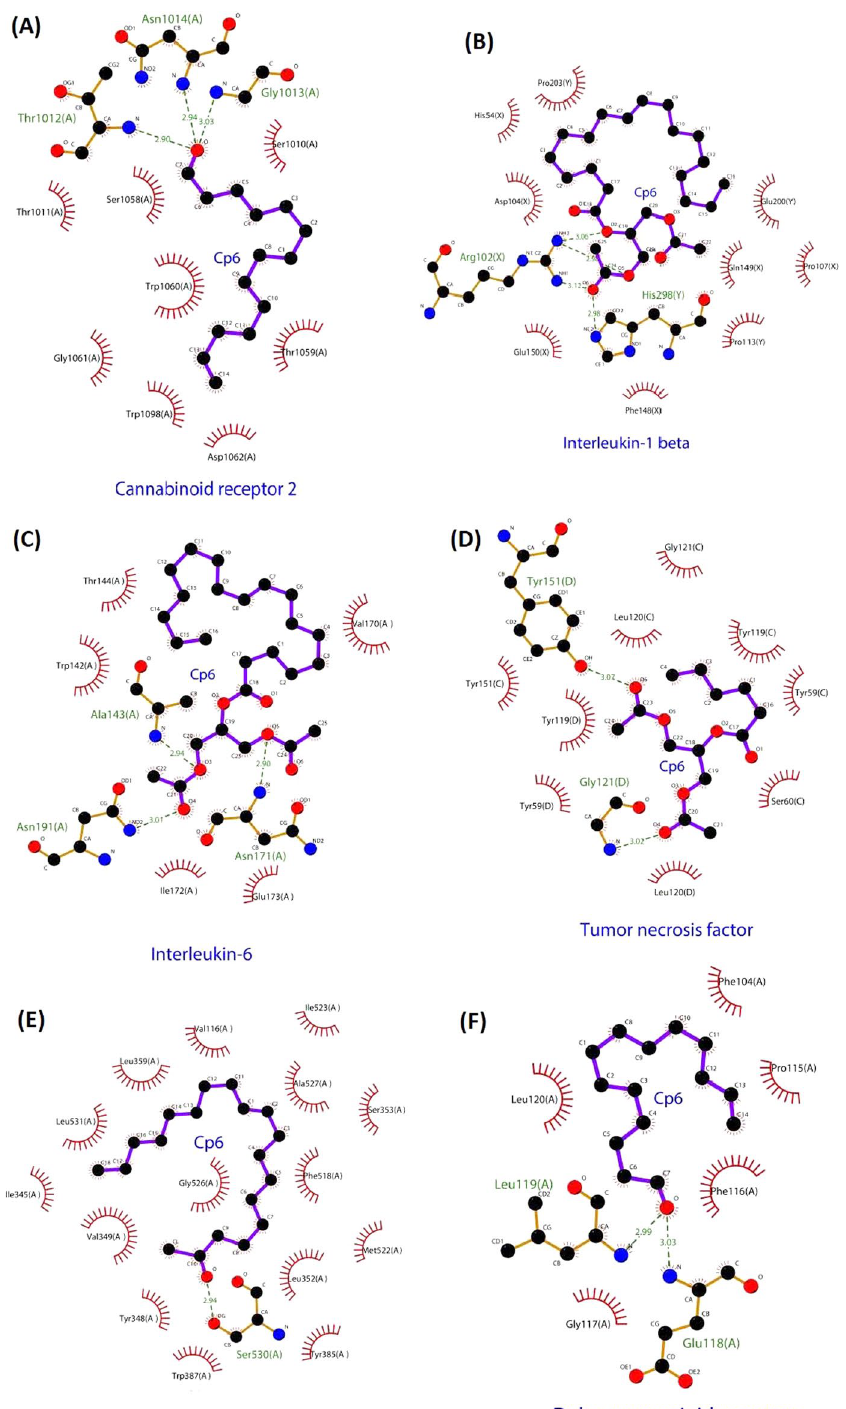
Fig. 11 2D interaction of the hydrogen bond in Oleoyl chloride (Cp6) and six selected target proteins of Ruellia herbs. The dashed green lines indicate hydrogen bond and its length; brown line indicates non-ligand bond; purple lines indicate the ligand bonds; red-eyelash symbol with dashed red line indicate non-ligand residue involved in hydrophobic interaction; black dots with dashed red line indicate corresponding atoms involved in hydrophobic